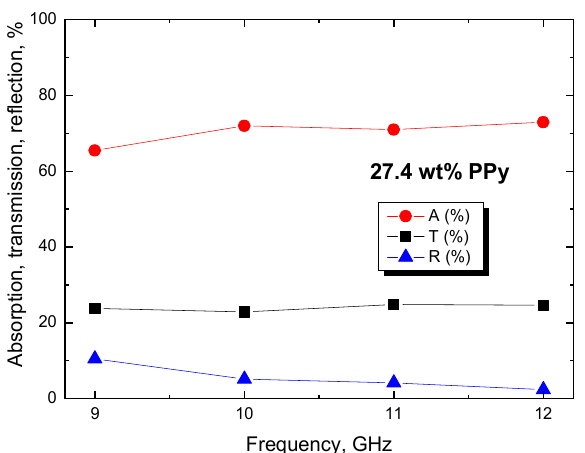
Figure 13. Radiation frequency dependence of absorption, transmission and reflection contributions tested on the original sponge containing 27.4 wt% polypyrrole.